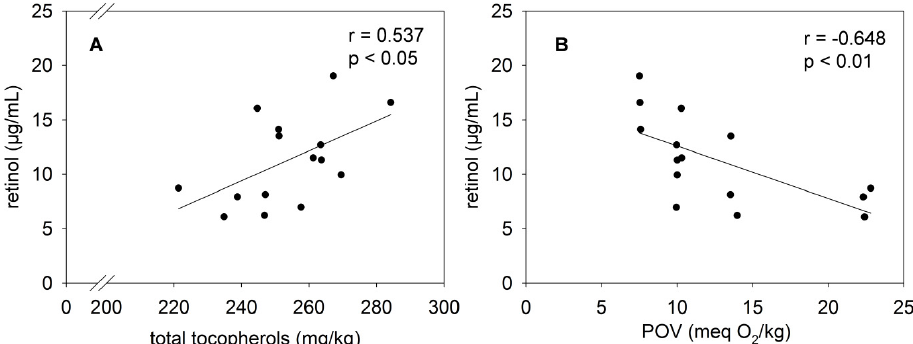
Figure 6. Correlation between the retinol concentration and the total tocopherol content ( A ) and